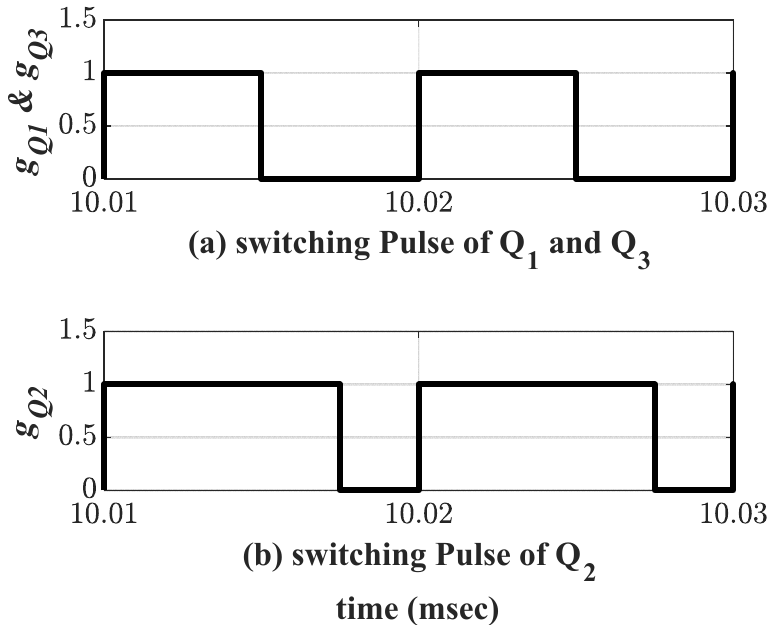
Figure 6. Gate pulses of the switches at the simulated test point.